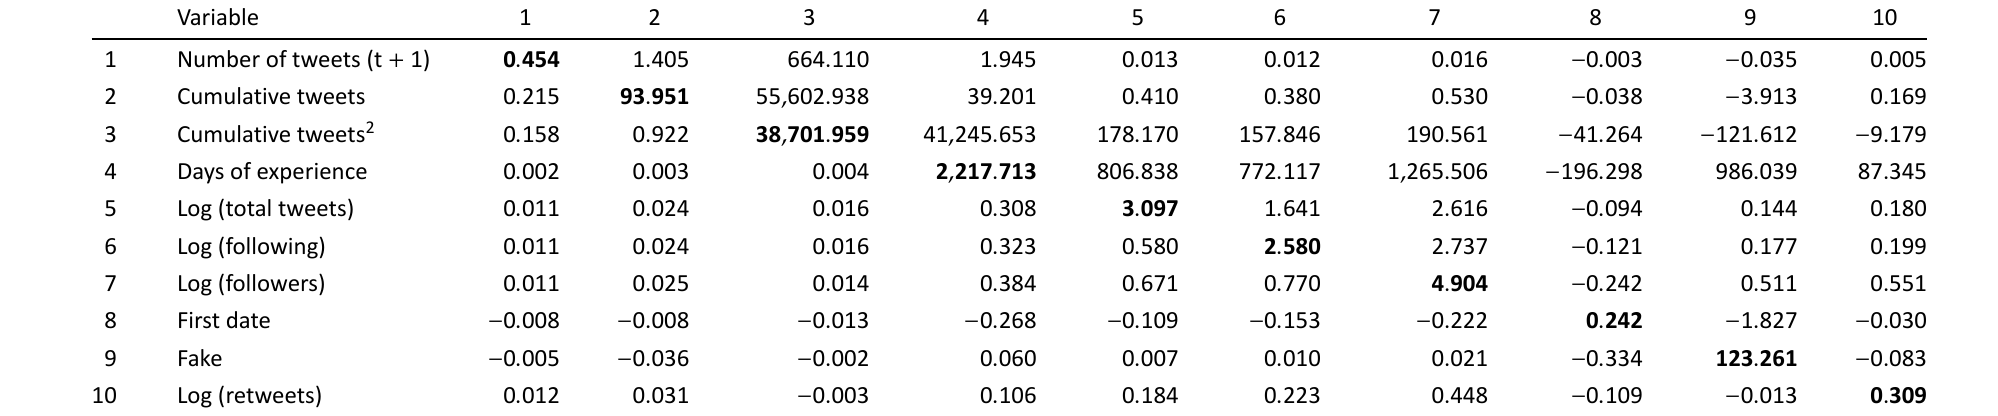
Table 6. Correlation‐variance–covariance matrix of key variables in the lower left, diagonal, and upper right